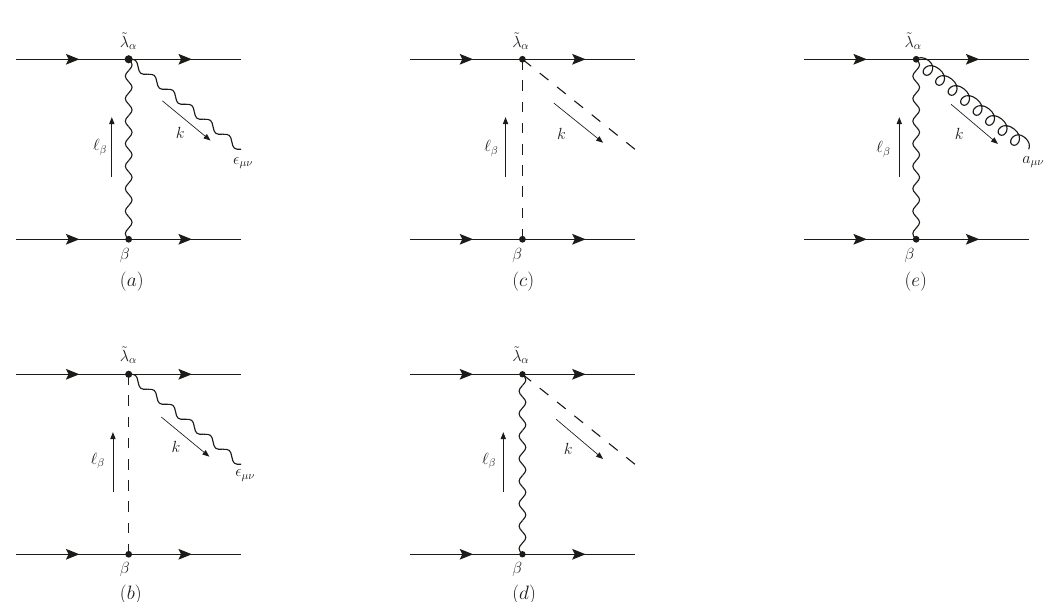
Figure 3 . The leading order radiation for spinless sources with (cid:12)nite-size corrections. The dotted lines represent dilatons, the coiled lines are axions, and the thin wavy lines mean gravitons. The (cid:12)rst column contributes to graviton channel, the second are responsible for dilaton channel, and the third gives the radiation in axion